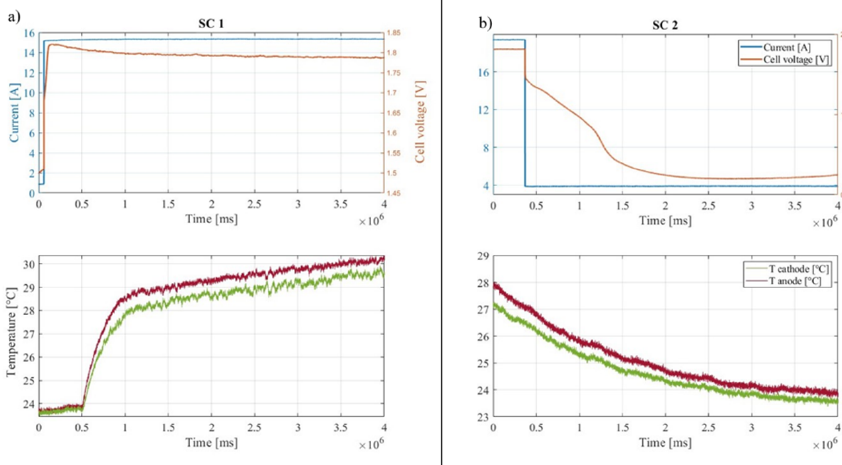
Figure 6. Obtained experimental results: ( a ) SC1 (0–15 A), and ( b ) SC2 (15–0 A).